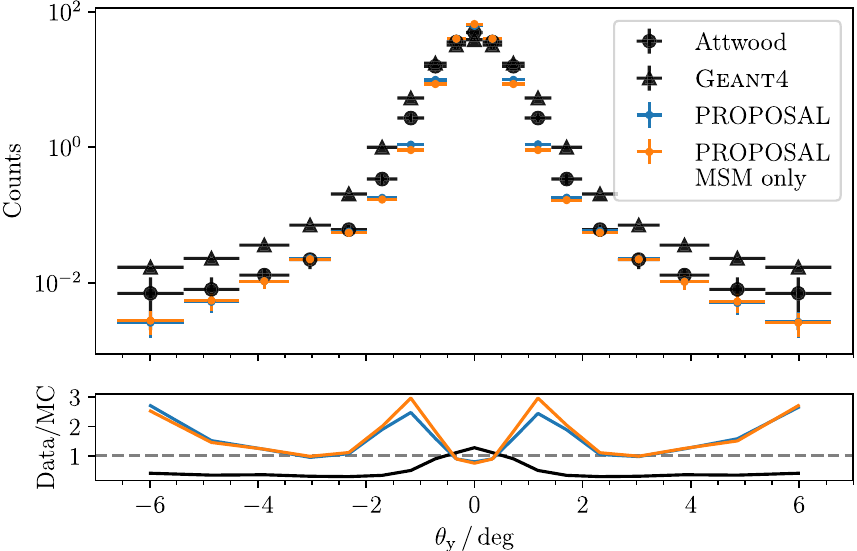
Fig. 3 Muons are propagated with E i = 199 MeV through 109 mm of liquid H 2 . Measured data of Attwood et al. and simulation data of Geant4 are taken from Ref. [28]. The figure presents the normalized counts in dependence of the projected scattering angle θ y in degree. In PROPOSAL, 100 simulations each with 10 5 muons are performed for two different settings using the energy cut v cut = 10 − 5 . The blue points present the mean of the simulations considering stochastic deflections and Molière scattering (MSM), the orange points present the mean of